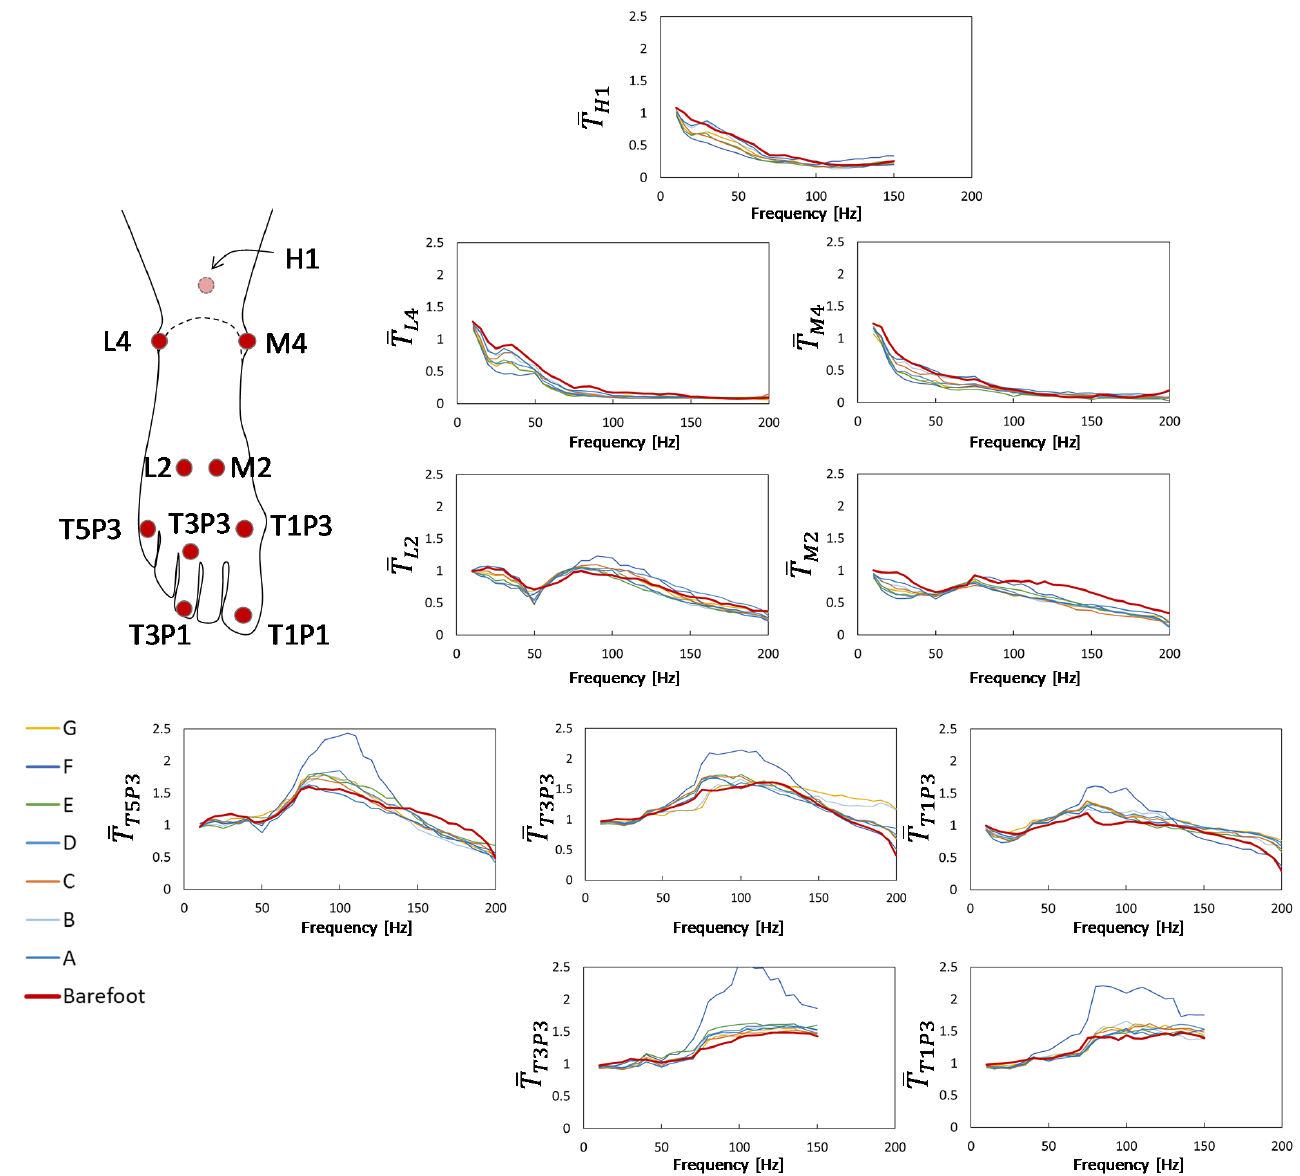
Figure 4. Average transmissibility T m , F ( f )